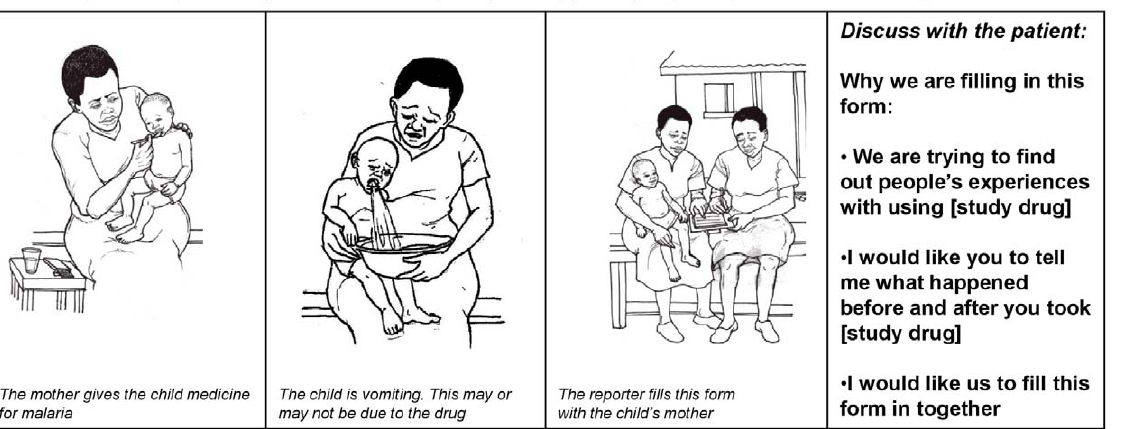
Figure 3. Pictorial strip after workshops and pretesting for active reporting.